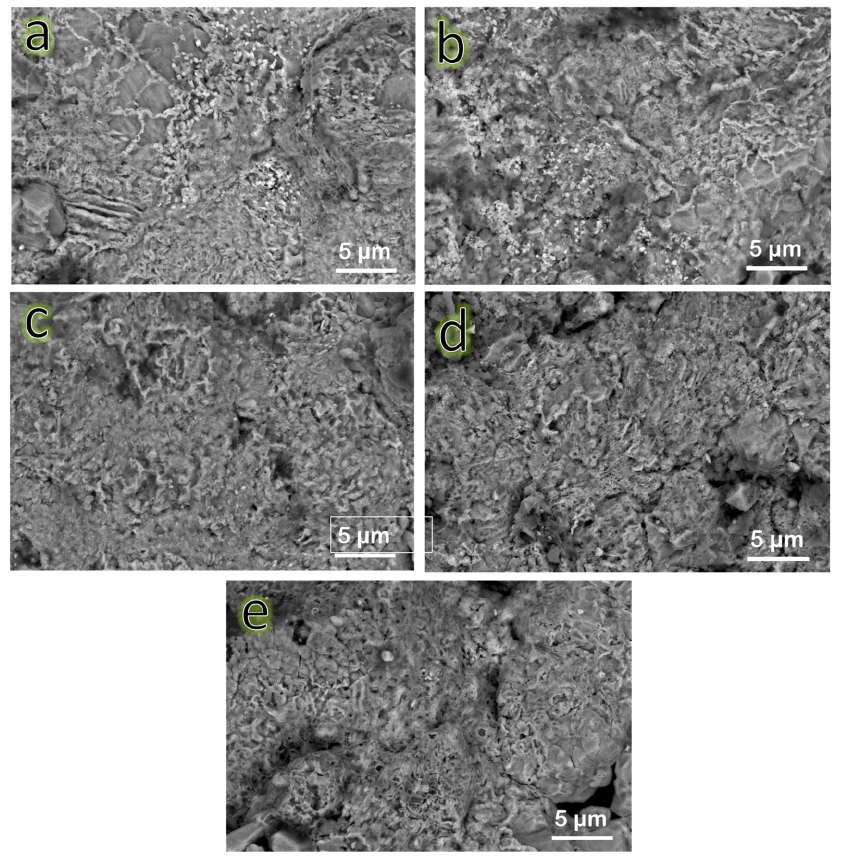
Figure 7. SEM images of ( a ) FNG0, ( b ) FNG1, ( c ) FNG2, ( d ) FNG4, and ( e ) FNG8 samples sintered at 1150 °C.